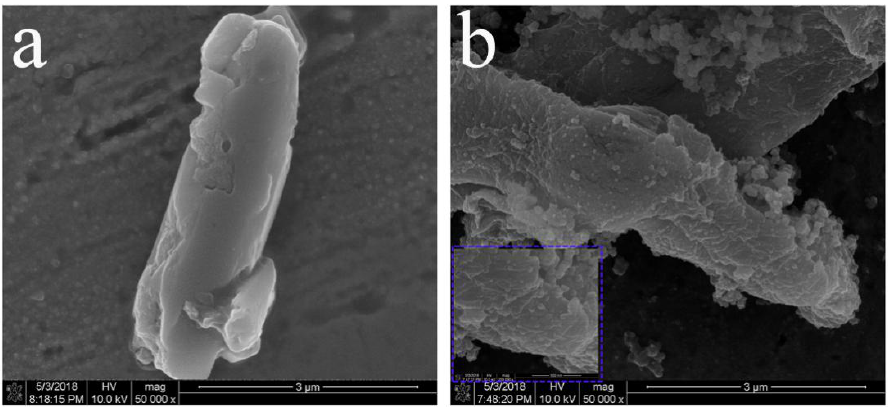
Figure 4. FESEM images (scale bar = 3 μm) of DAC ( a ), and SiO 2 /DAC (1/2) ( b ) (Small figure at bottom left has a magnification of 200,000 (the blue dashed outline). Bars, 500 nm.).